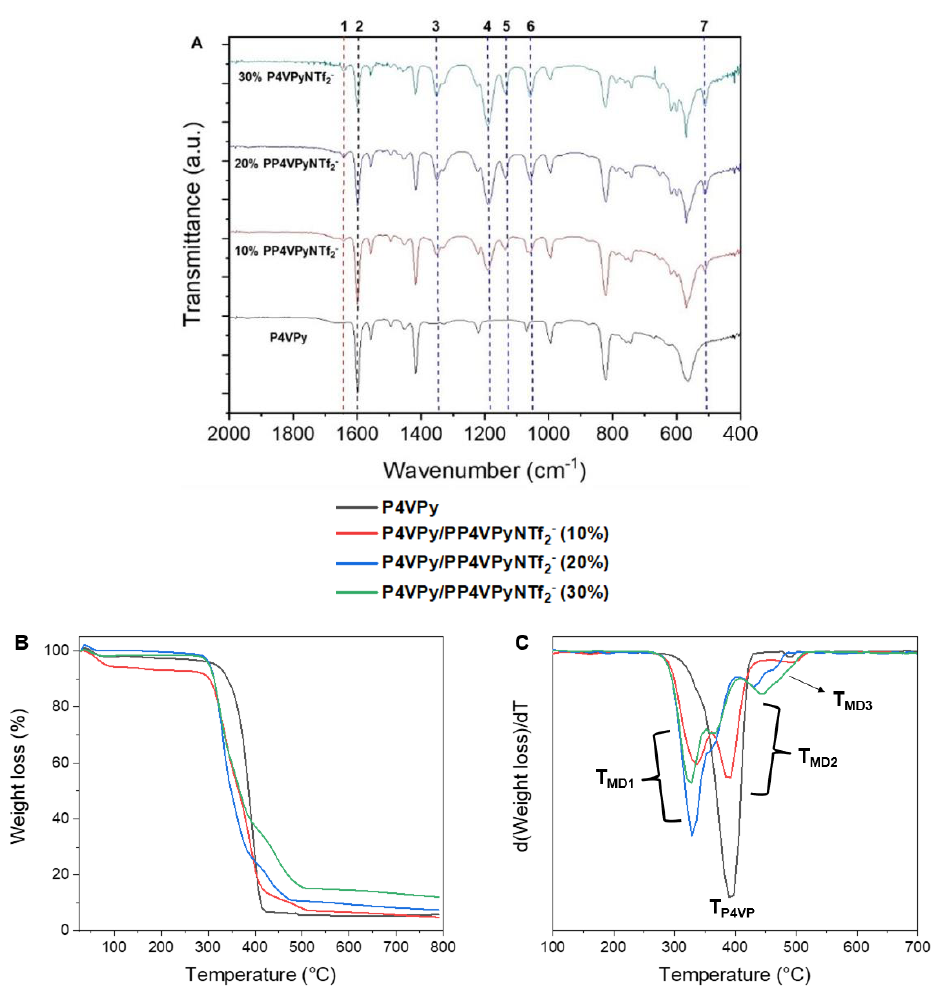
Figure 4. ( A ) FT-IR spectra of the P4VPy and P4VPy/PP4VPyNTf 2 − nanofibers, ( B ) thermal decom- position profiles of P4VPy and P4VPy/PP4VPNTf 2 − nanofibers, and ( C ) curves of the corresponding weight loss derivatives with temperature.